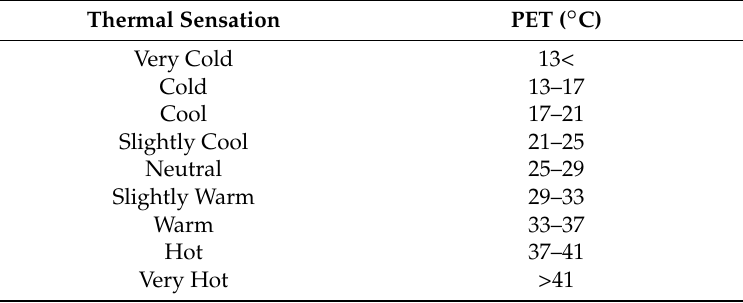
Table 4. Thermal sensation of a hot-summer and warm-winter climate region [50].